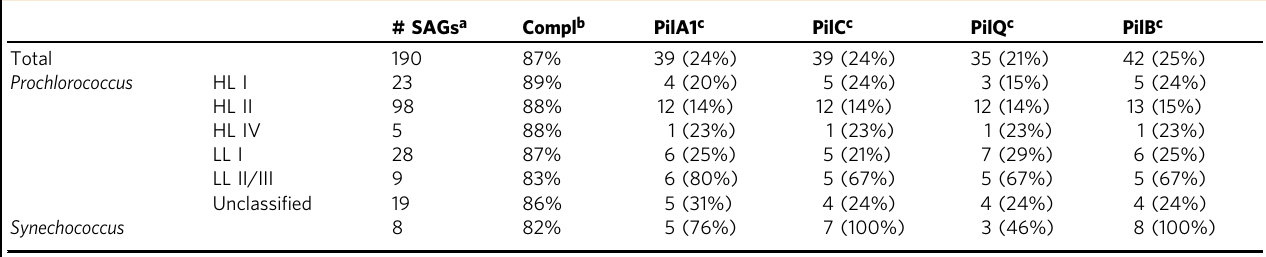
Table 1 PilA1 and pilus apparatus distribution among planktonic marine SAGs.